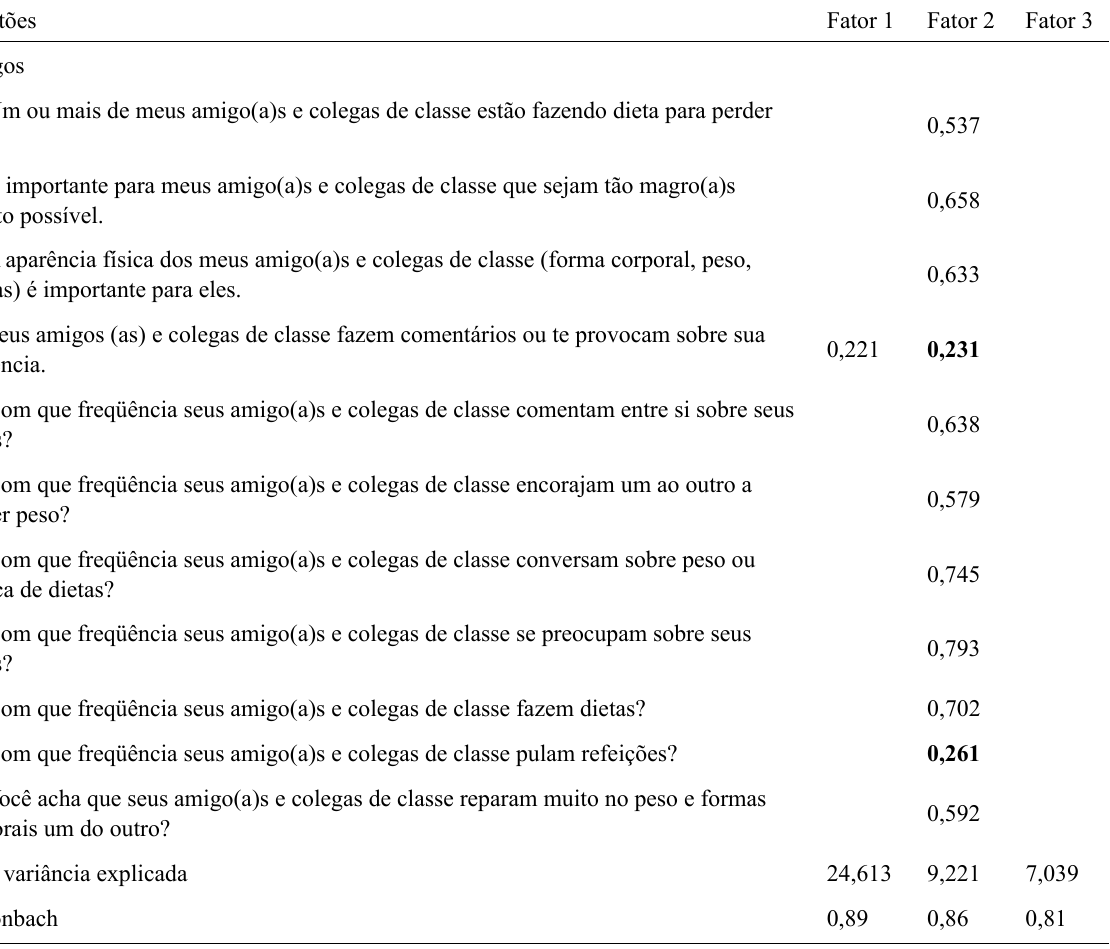
dos itens deste construto carregam neste fator com